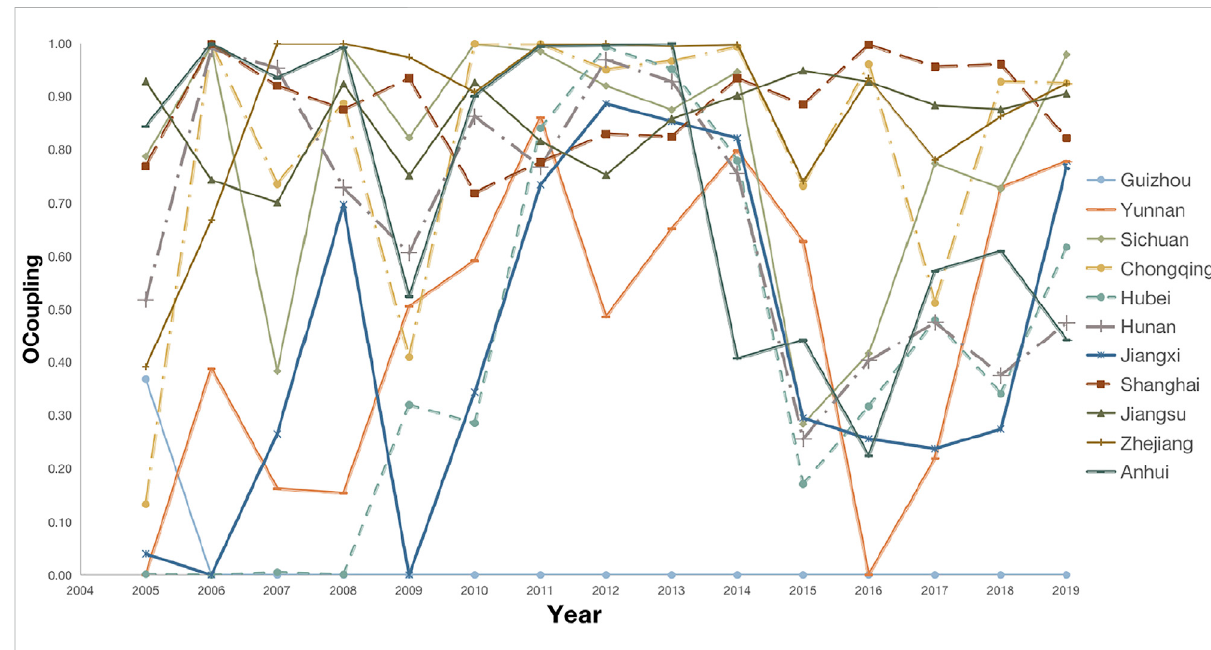
FIGURE 5 Evolution of two-way FDI coupling in the Yangtze River Basin, 2005 –